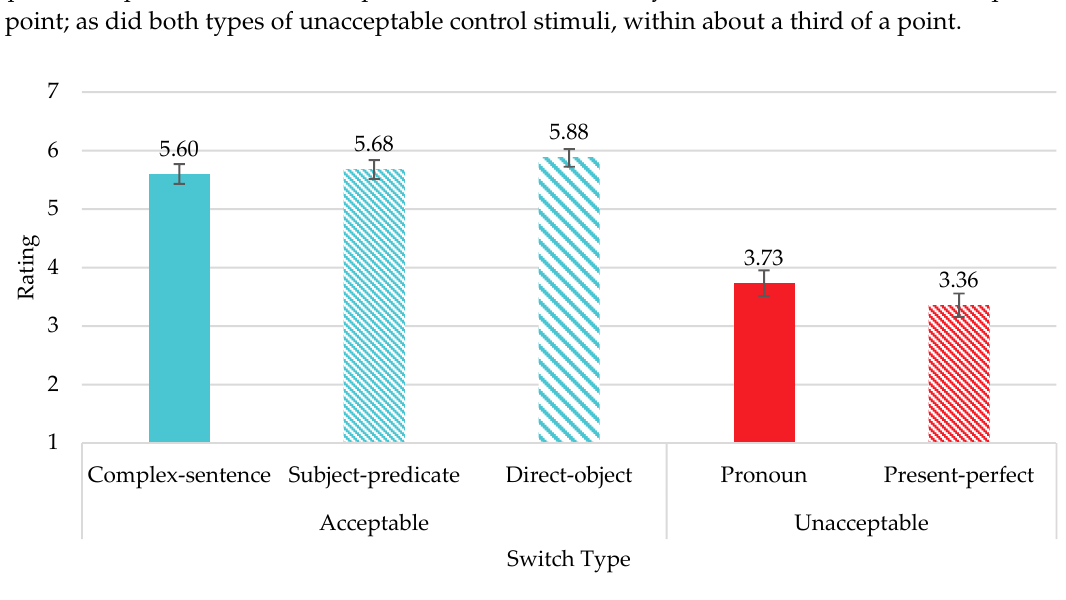
Figure 2. Mean rating of control stimuli by participant and stimulus type. A two-way ANOVA revealed that there was a statistically significant interaction between participant and stimulus type, F (19,560) = 6.781, p < 0.001. Simple main effects analysis showed that